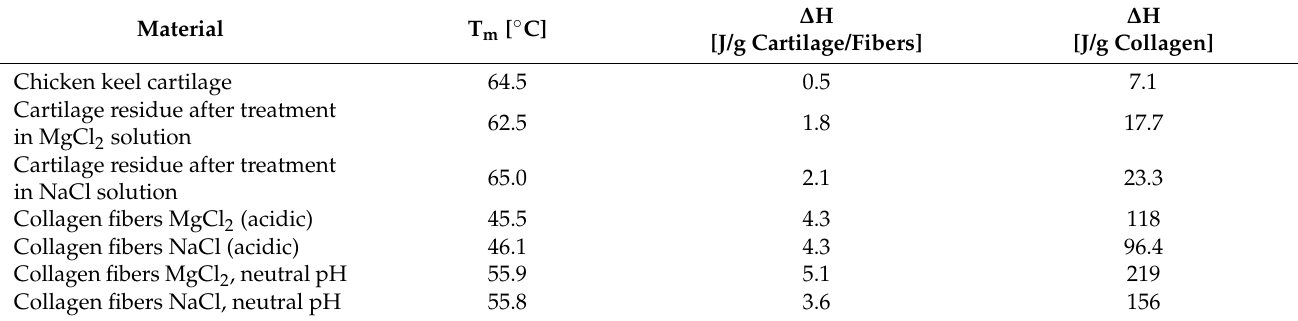
Table 4. Thermal characteristics of cartilage and collagen fibers determined by scanning